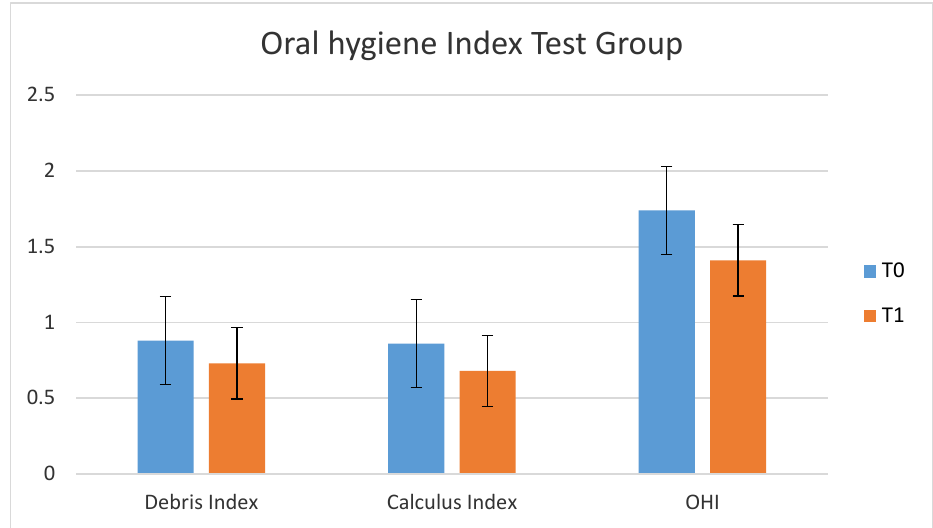
Figure 2. Oral Hygiene Index (score) reported for the test group patients at different times (T0–T1).